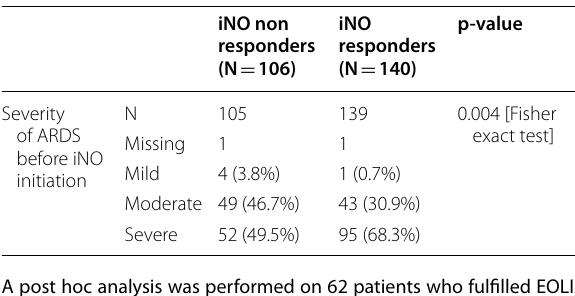
Table 1: Severity of ARDS at iNO initiation in iNO responders and non responders